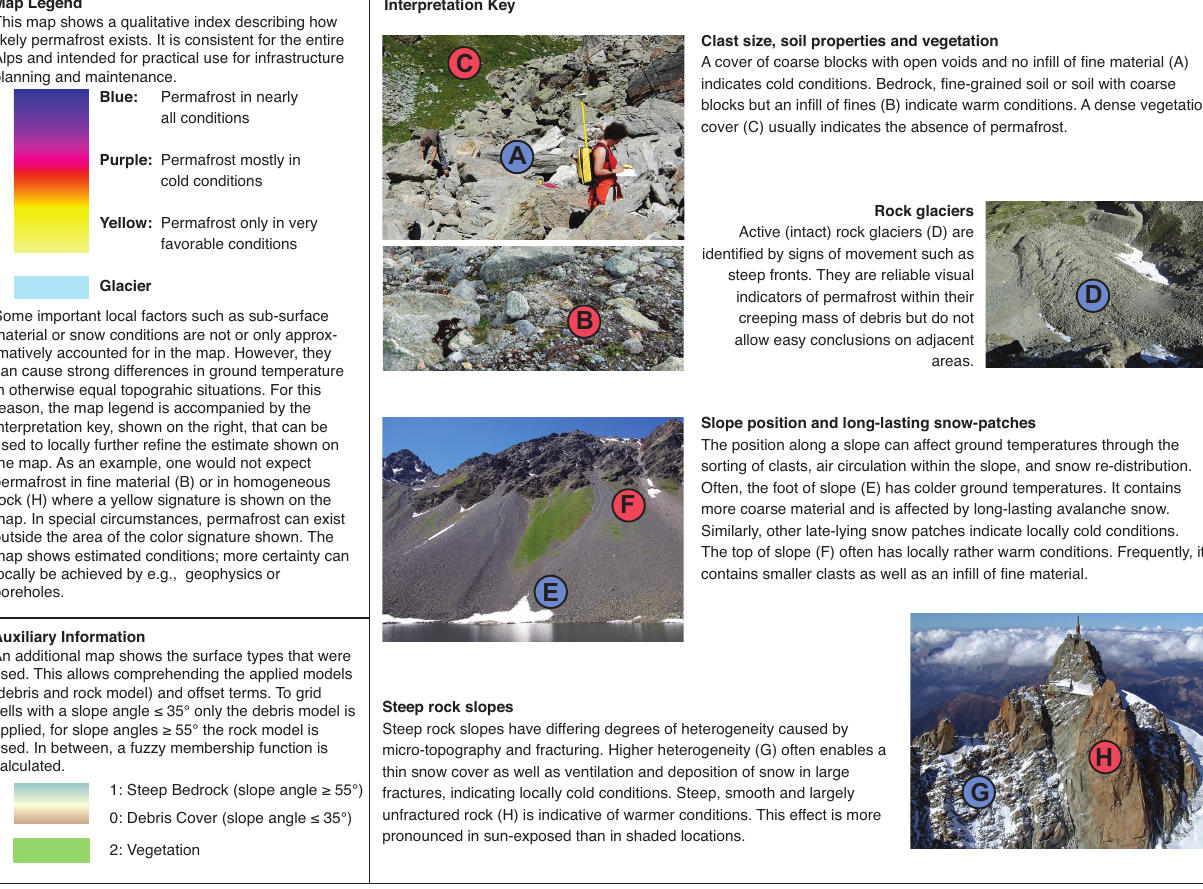
Fig. 10. Legend, interpretation key and auxiliary information that is provided with the Alpine Permafrost Index Map (APIM). This informa- tion helps to assess map uncertainties, to relate map contents to their actual expression in terrain and to comprehend the applied models and offset